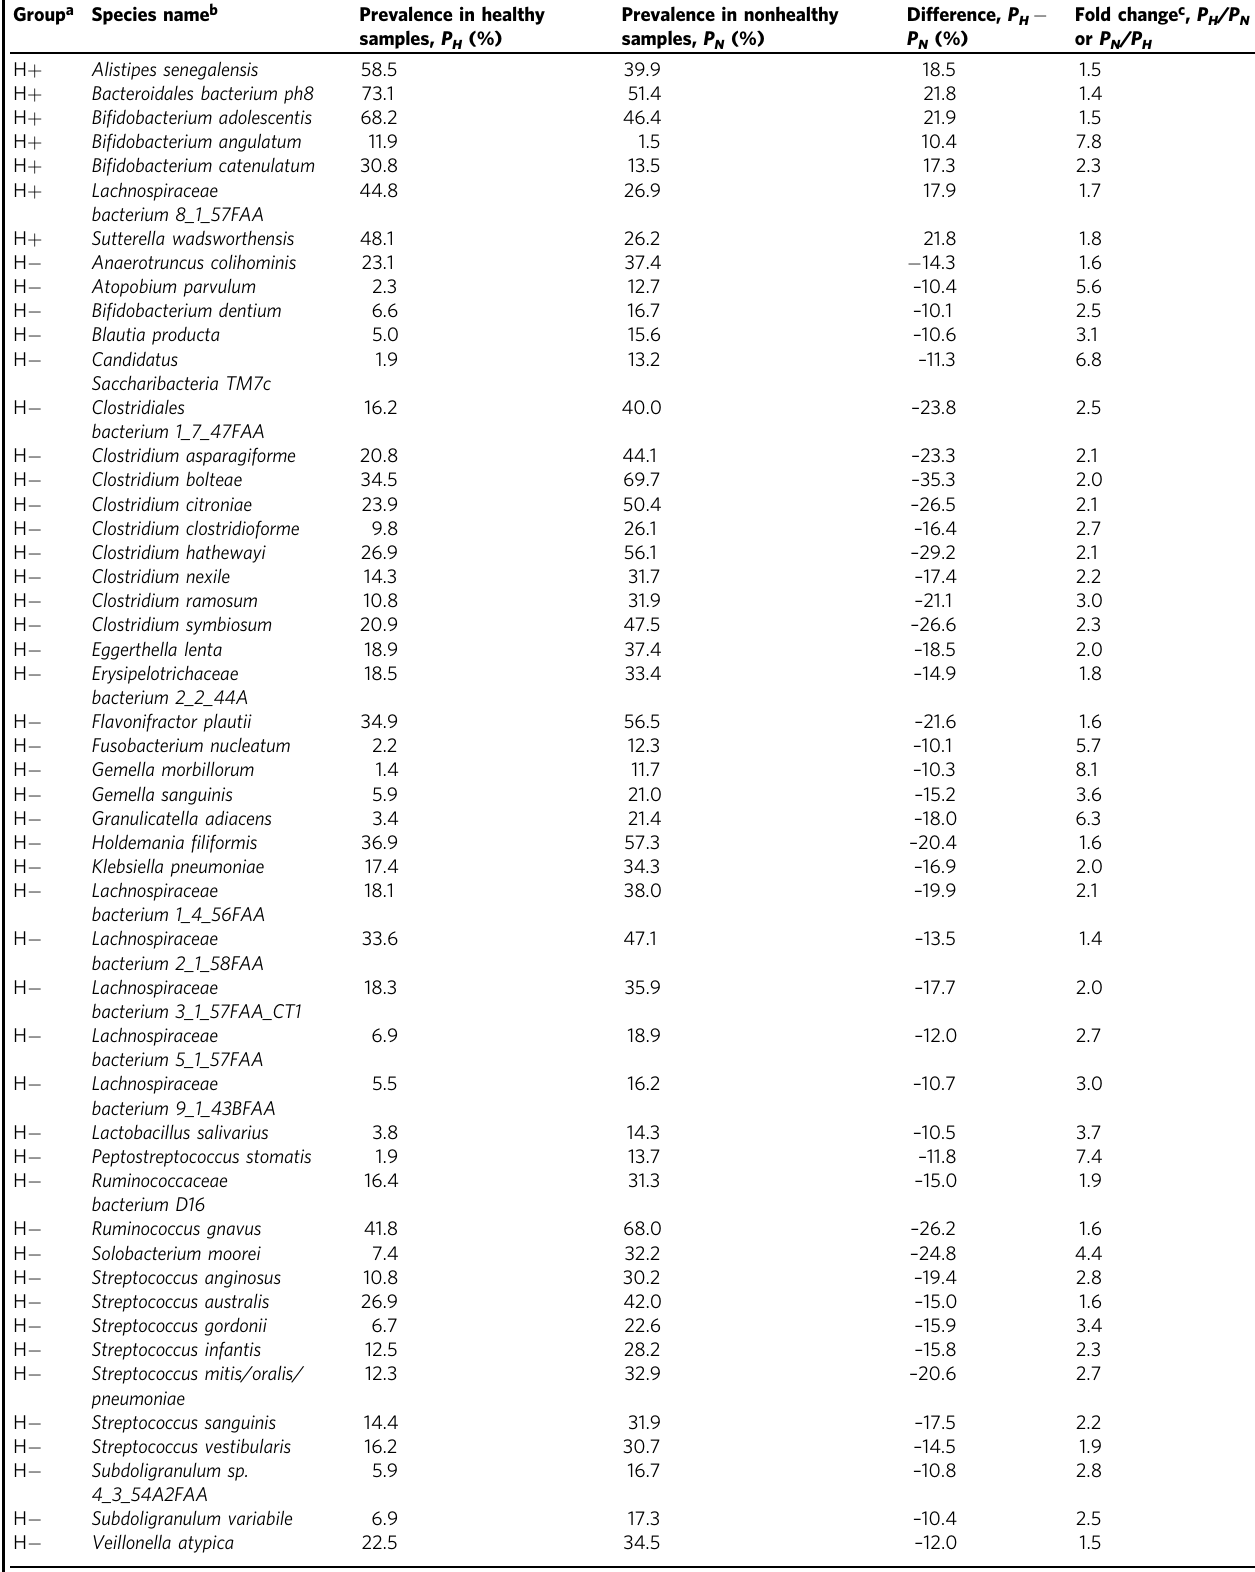
Table 2 Microbial species of the Health-prevalent and Health-scarce